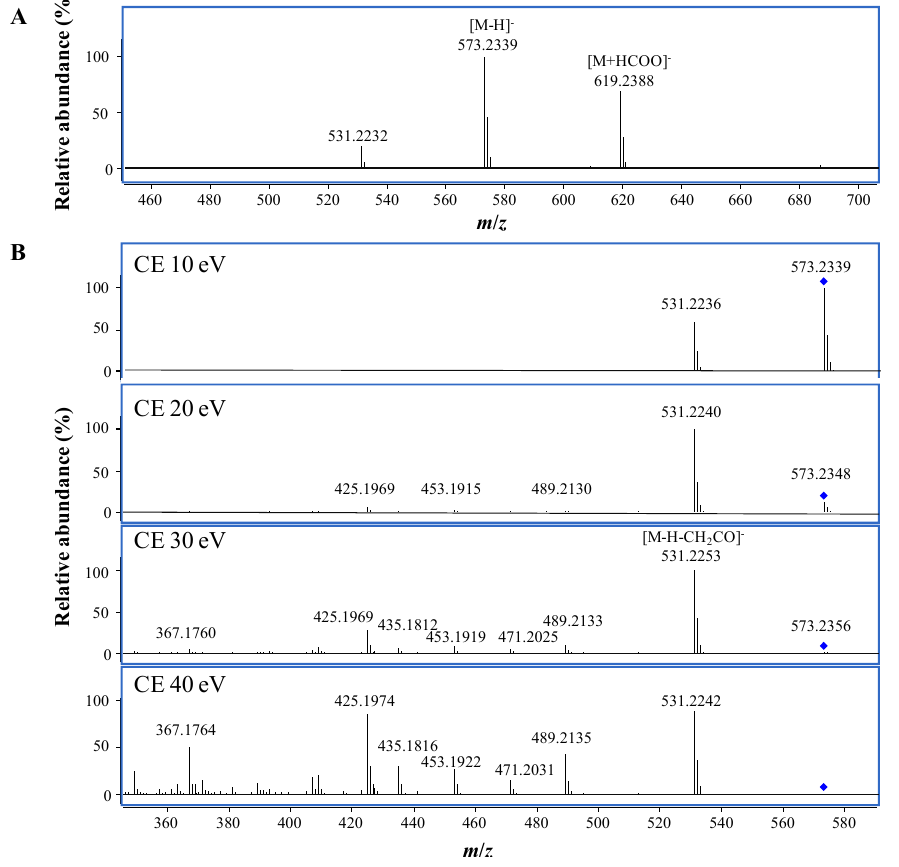
Figure 2. ( A ) MS and ( B ) MS/MS spectra of toosendanin at different collision cell energies (CE) in negative